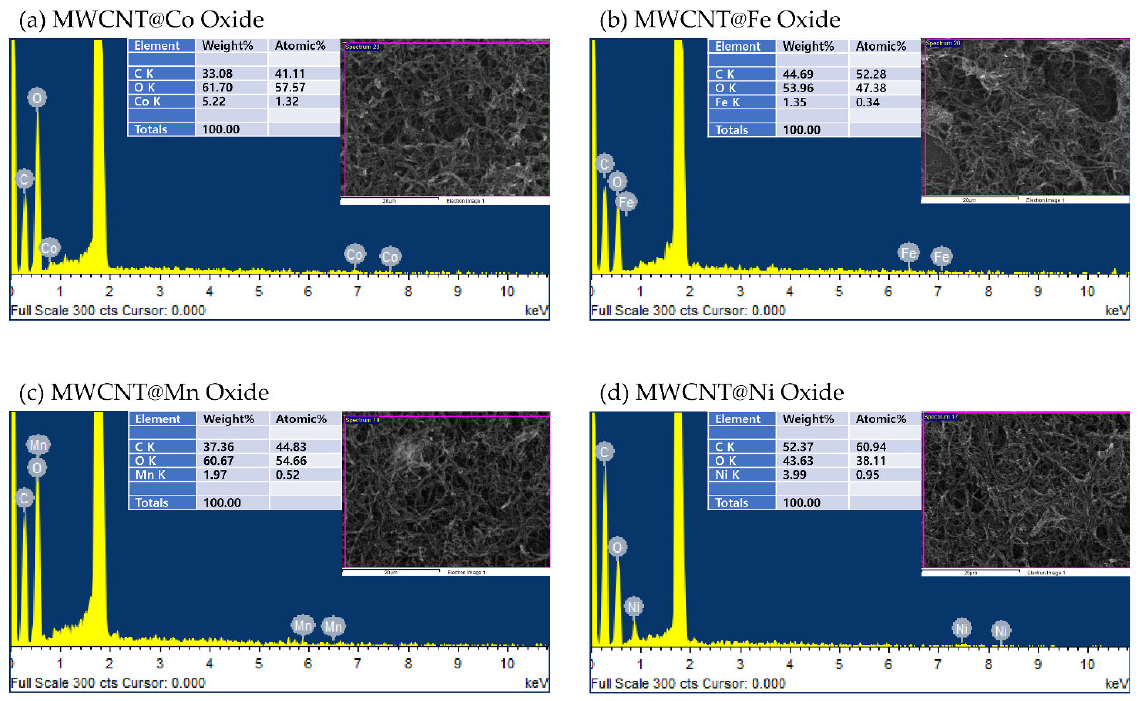
Figure 4. SEM images and EDS spectrum with content of MWCNT@metal oxide NP composites.